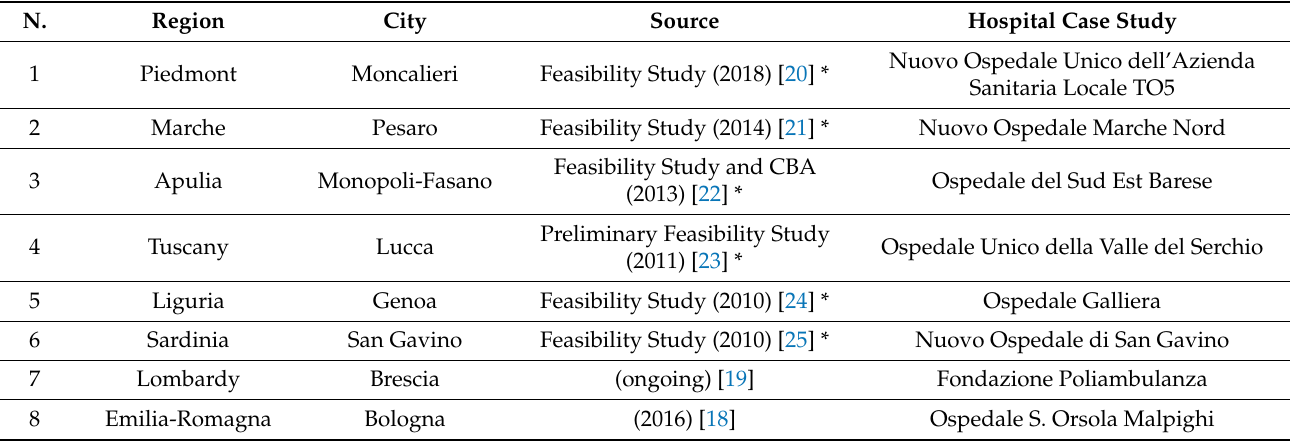
Table 1. Analyzed case studies overview.